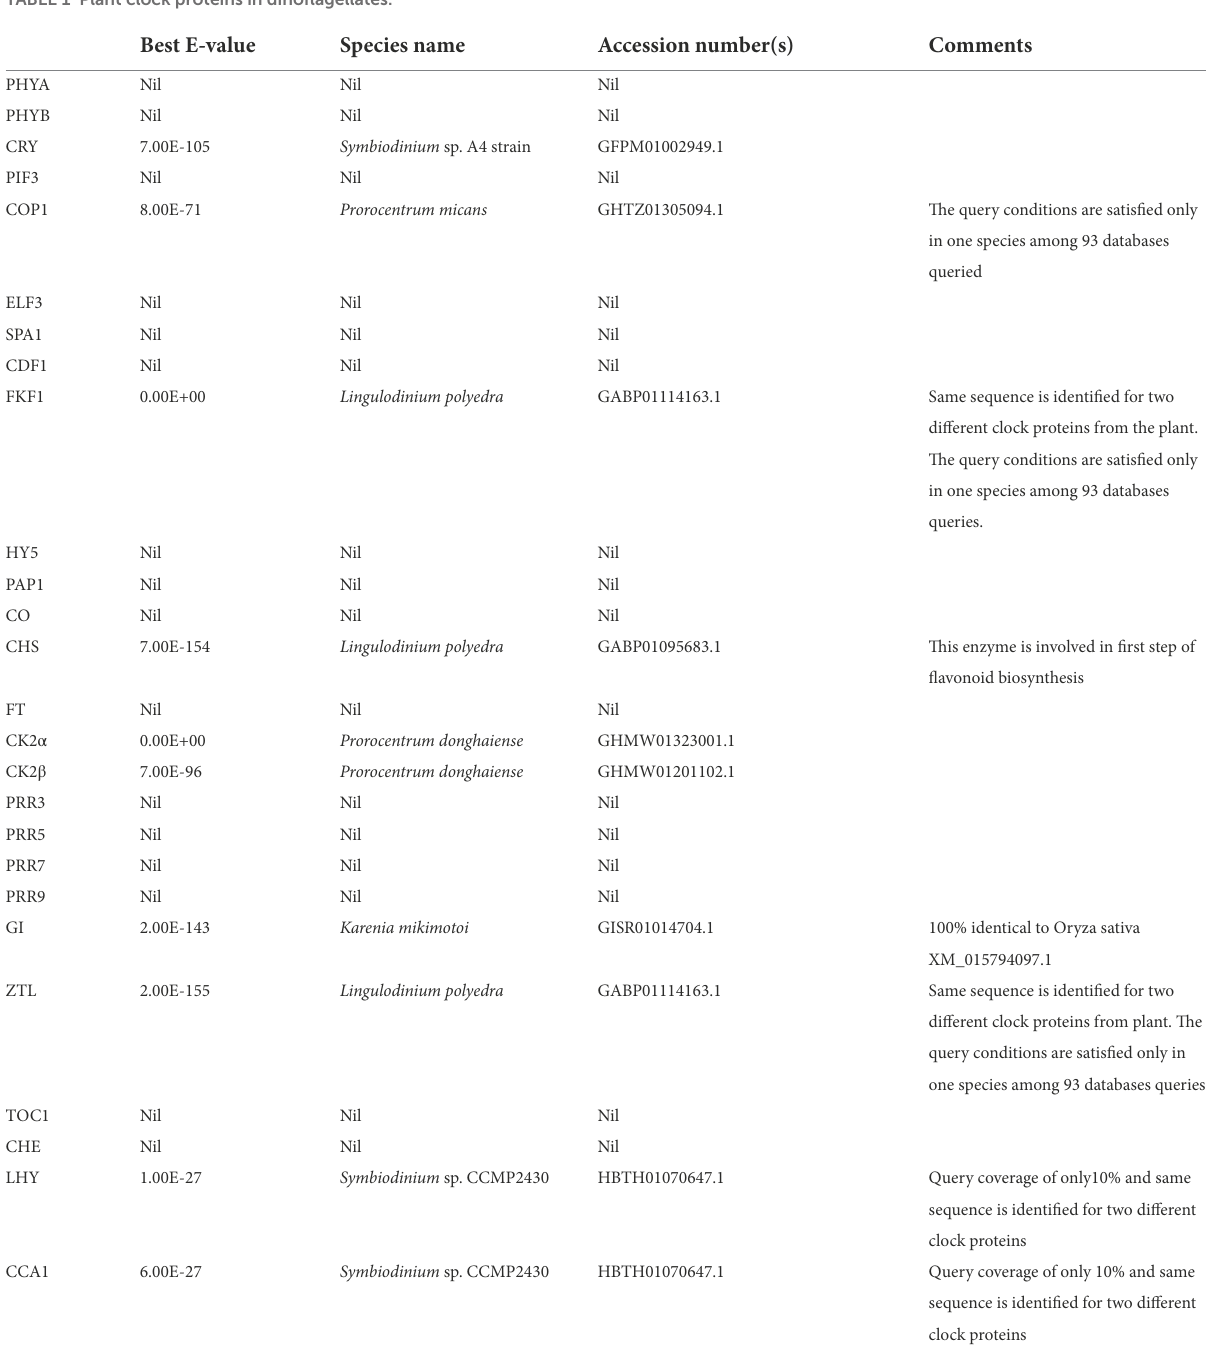
TABLE 1 Plant clock proteins in